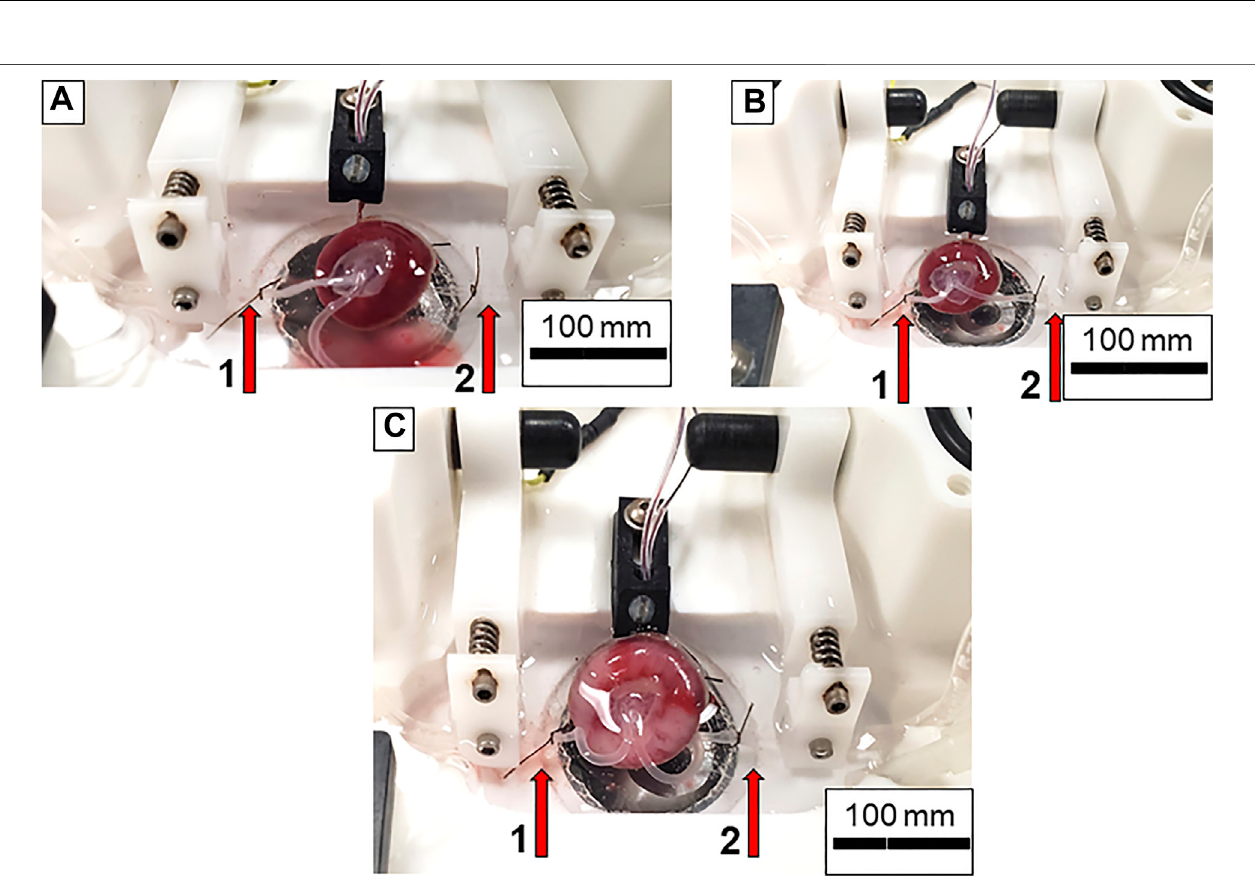
FIGURE4 | Preparation ofthe placental unit prior tostartingan experiment. (A) The umbilical arteryiscanulatedonto the in fl owpressure canula while the umbilical vein is left united in order to clear the blood from the placenta. Note the pooling blood in the bottom of the chamber as PSS is fl owing through the placenta. (B) Both umbilical artery and vein are placed onto and tied to the in fl ow and out fl ow cannulas, respectively. No pressure is being applied to the system. (C) The placenta is fully pressurized. Note the increase in size and volume of the vessels within the chamber. Again, red arrows indicate in fl ow (left, 1) and out fl ow (right, 2) pipettes.